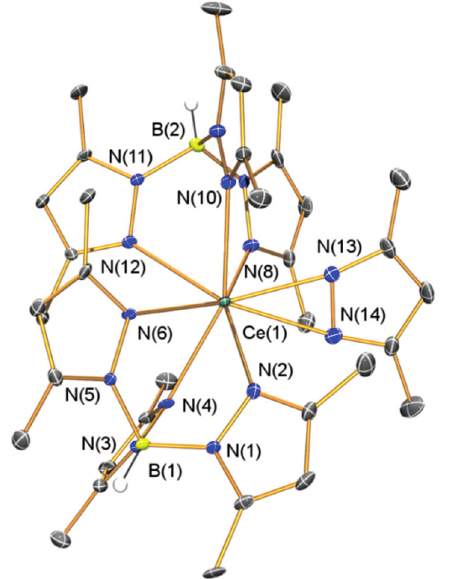
Figure 1. Molecular structure of 1 ·C 7 H 8 with selective atom labeling. Displacement ellipsoids set at 30% probability level and hydrogen atoms (except B–H) and lattice solvent omitted for